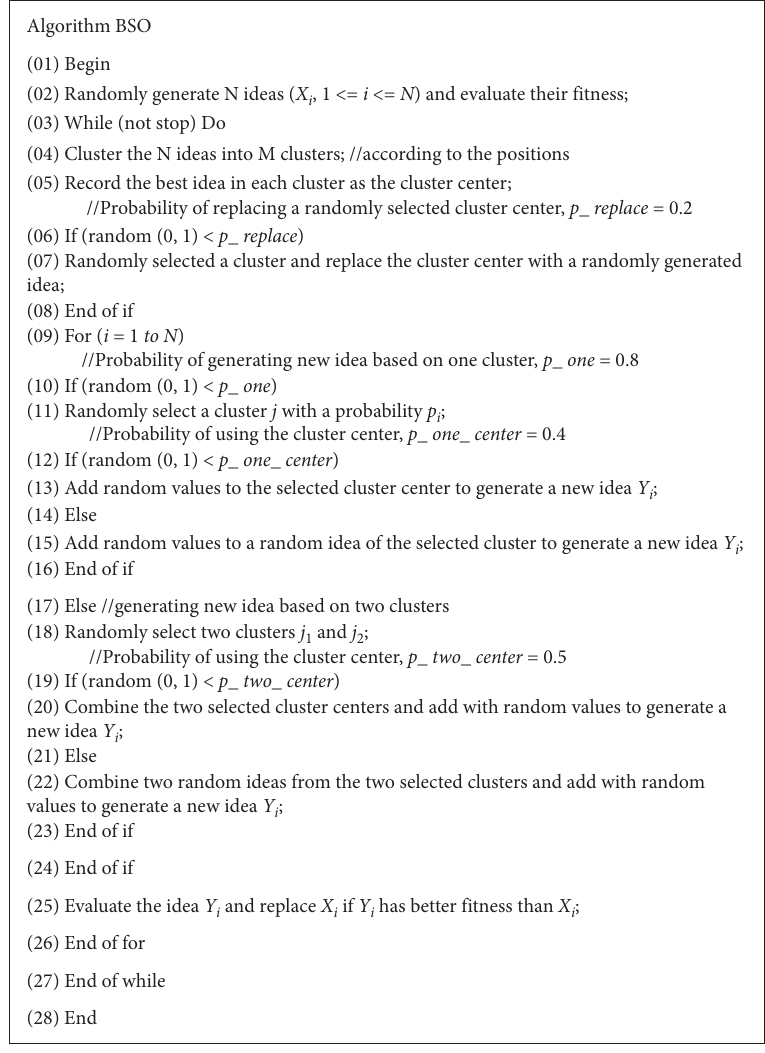
Figure 2: Pseudocode of brainstorm optimization